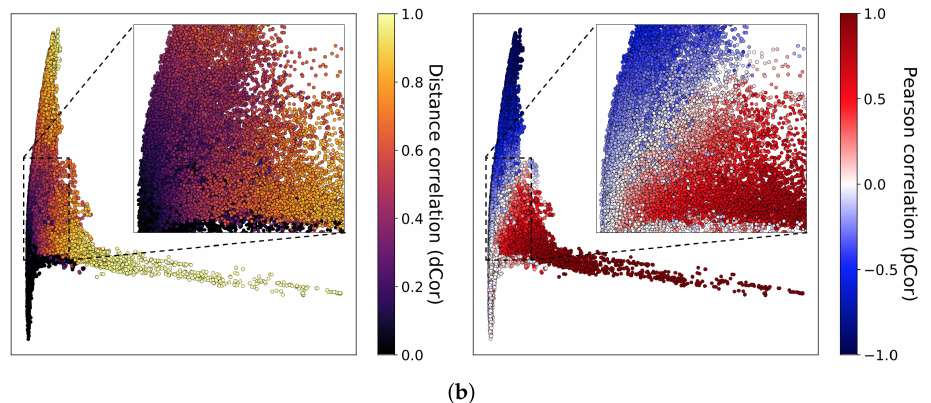
Figure 7. Visualizations of the dependence representations of the test set. ( a ) t-stochastic neighbor embedding (t-SNE), ( b ) principal component analysis (PCA).